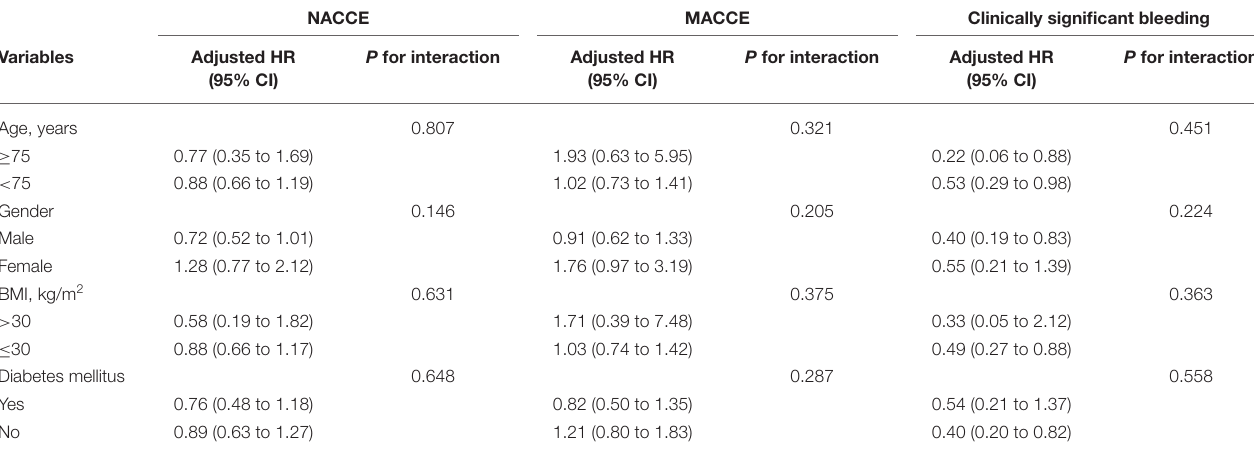
TABLE 3 | Risk for primary and secondary endpoints according to selected subgroups of study